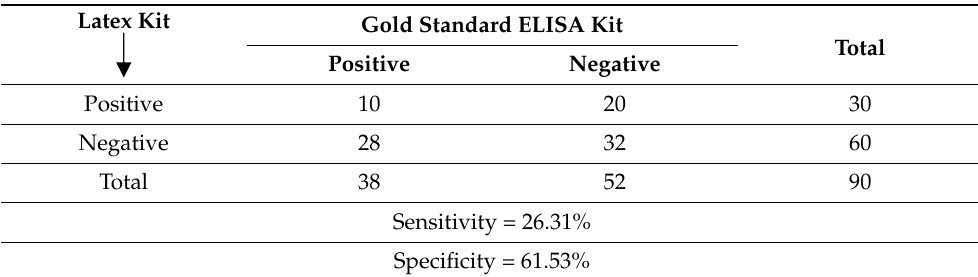
Table 5. Calculation of sensitivity and specificity of Latex Agglutination kit against Gold Standard ELISA kit (Commercial ELISA kit) ( n = 90).